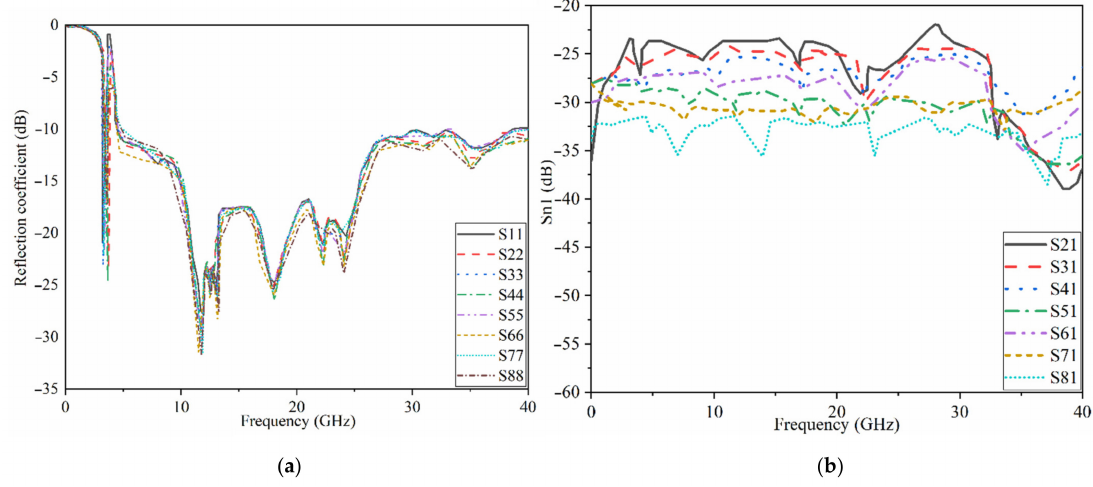
Figure 20. Simulated frequency response results of the proposed MIMO antenna for a mobile handset communications co: ( a ) reflection and ( b )